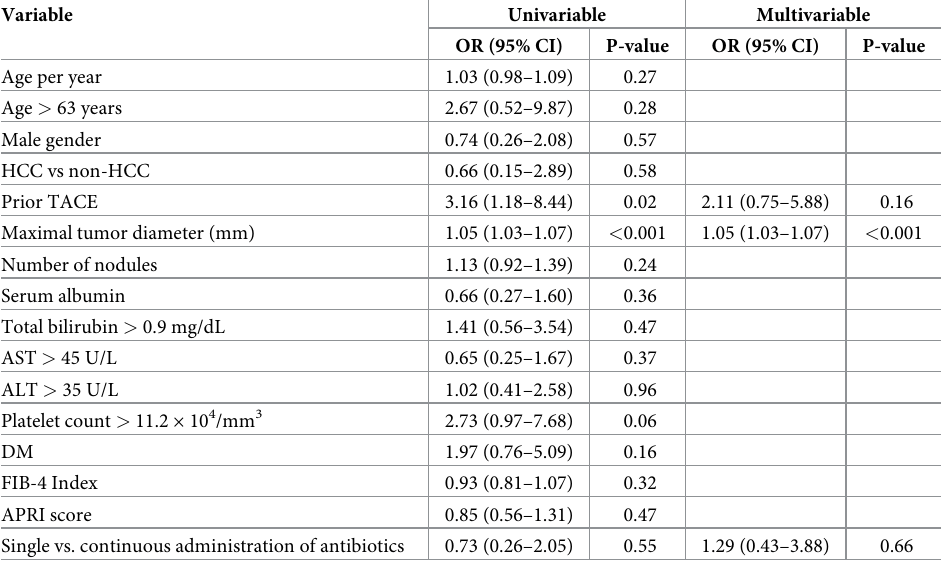
Table 4. An ad-hoc analysis with a dataset excluding overlap cases. Univariable and multivariable analyses of infec- tious